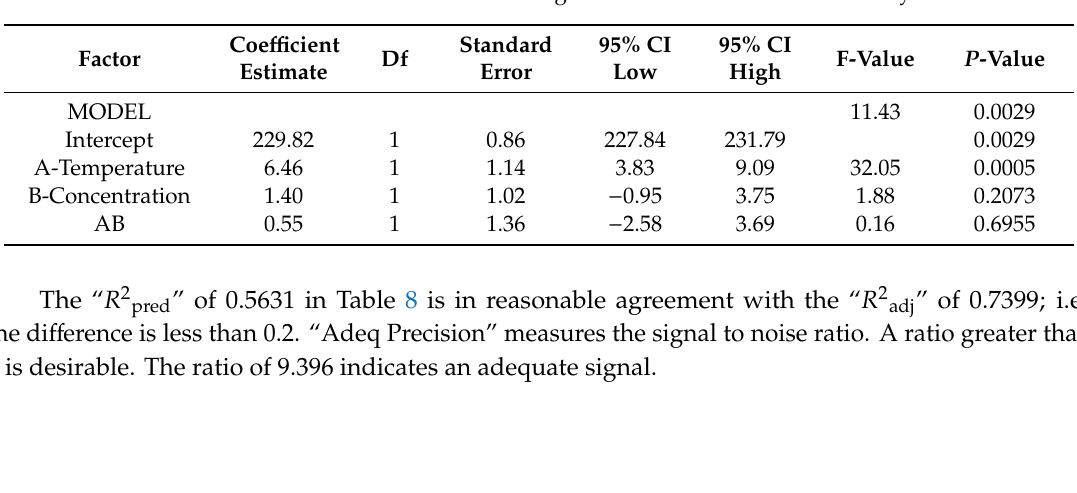
Table 7. The 2-factor interactions model regression coe ffi cients statistical